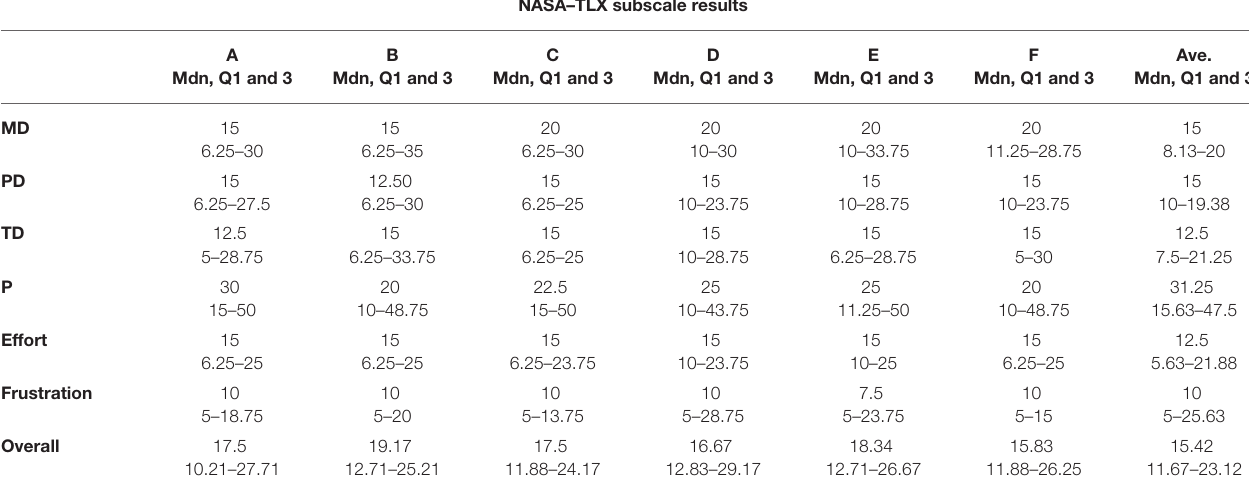
TABLE 8 | NASA-TLX